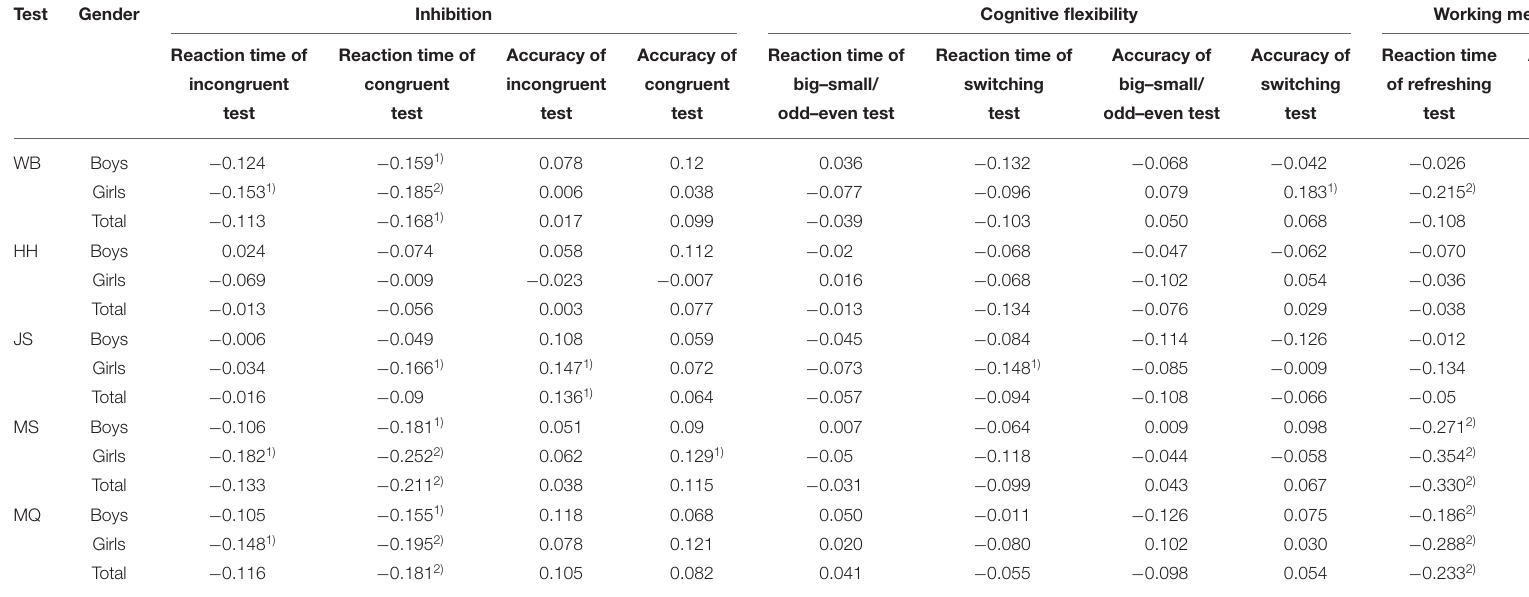
TABLE 2 | Correlation between gross motor coordination and executive functions of children aged 9–10 years.